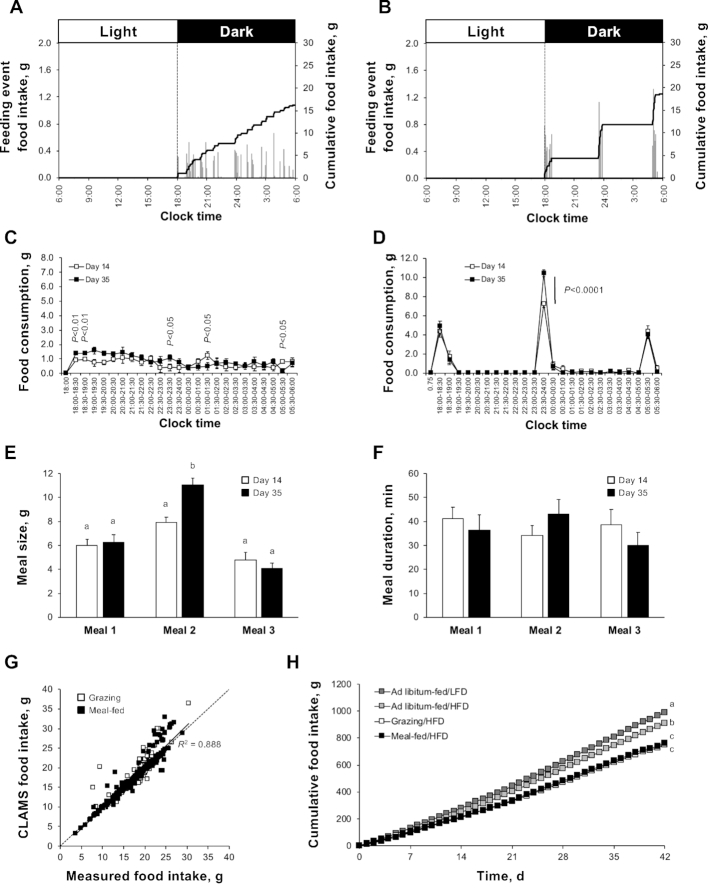
Delivery of HFD in grazing and meal-feeding patterns in male rats (study 2). Representative daily food intake profiles from day 14 of a 6-wk study in grazing (A) and meal-fed (B) rats consuming HFD (45% Atwater Fuel Energy fat). Each profile shows cumulative food intake (black line; right-hand axes) superimposed onto the individual feeding events (gray bars; left-hand axes). Comparison of the mean day-14 and day-35 food consumption profiles in grazing (C) and meal-fed (D) rats is shown, with quantification of the size (E) and duration (F) of the individual meals in meal-fed animals. Regression analysis of the Comprehensive Laboratory Animal Monitoring System output data with manual quantification of daily food consumption is shown (G; regression conducted for all data points; dashed line shows parity), with cumulative food consumption across the 6-wk study presented (H). Data shown are either representative individual profiles (A, B), or means ± SEMs [C–F, H; n = 6 (grazing and meal-fed)] with statistical comparisons performed by either paired Student's t test (C, D) or 1-factor ANOVA and Bonferroni's selected-pairs post-hoc test (E, F, H) (means without a common letter differ, P < 0.05). Note: groups of rats consuming an HFD or low-fat diet ad libitum (H; n = 9 both diets) were monitored in parallel to calculate food intake allowance for application to grazing rats. HFD, high-fat diet; LFD, low-fat diet.